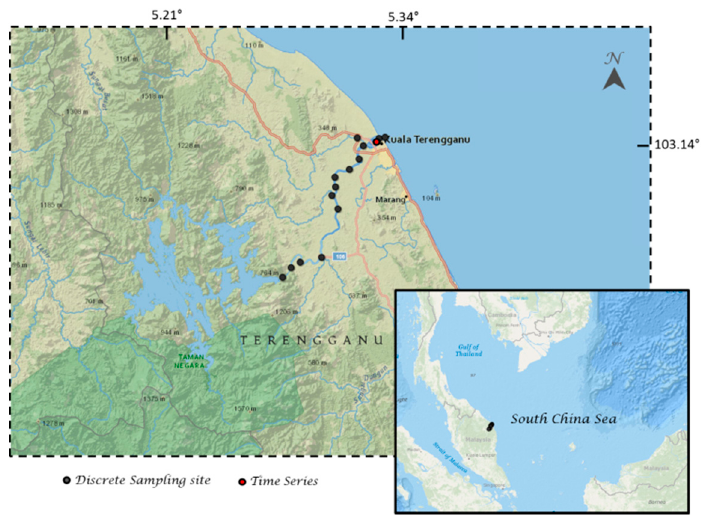
Figure 5. Map showing the observation region on the Terengganu river estuary, Malaysia.